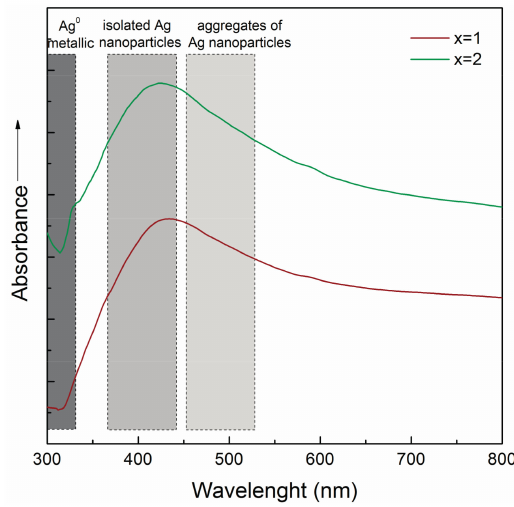
Figure 7. UV-vis spectra of the 60SiO 2 (32 − x)CaO · 8P 2 O 5 · xAg 2 O